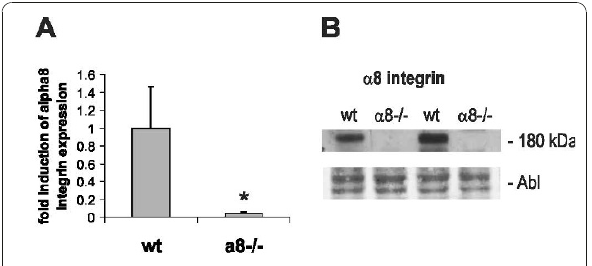
Figure 1 Mesangial cell expression of a 8 integrin in wild type (wt) and a 8 integrin-deficient mesangial cells ( a 8-/-) . A: Real- time RT-PCR analysis of a 8 integrin expression in wt and a 8-/- mesangial cells. B: Western blot analysis of a 8 integrin protein in wt and a 8-/- mesangial cells. Amido black (Abl) staining of the blot served as loading control. Results are representative for at least 3 similar experiments. Data are means ± sd. * p < 0.05 vs.